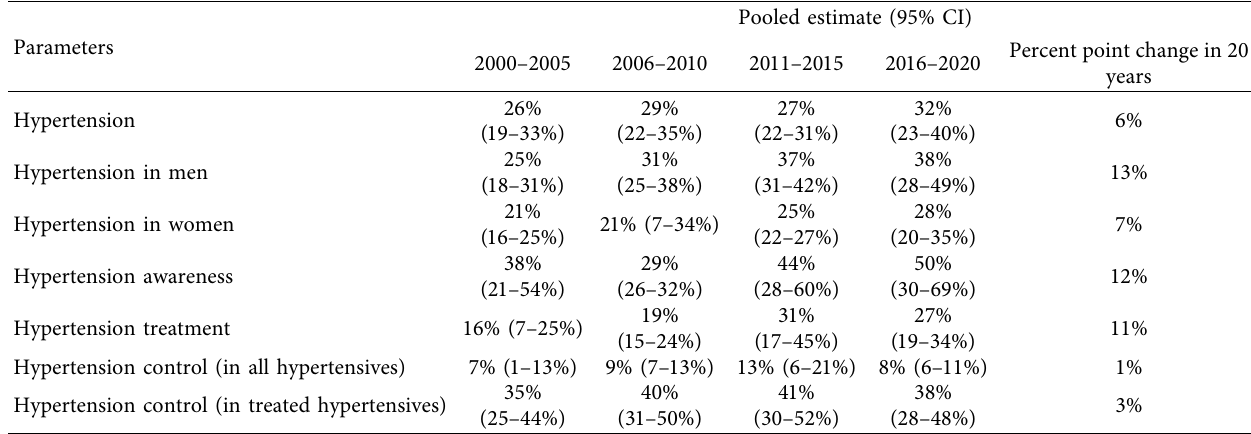
Table 2: Prevalence, awareness, treatment, and control of hypertension